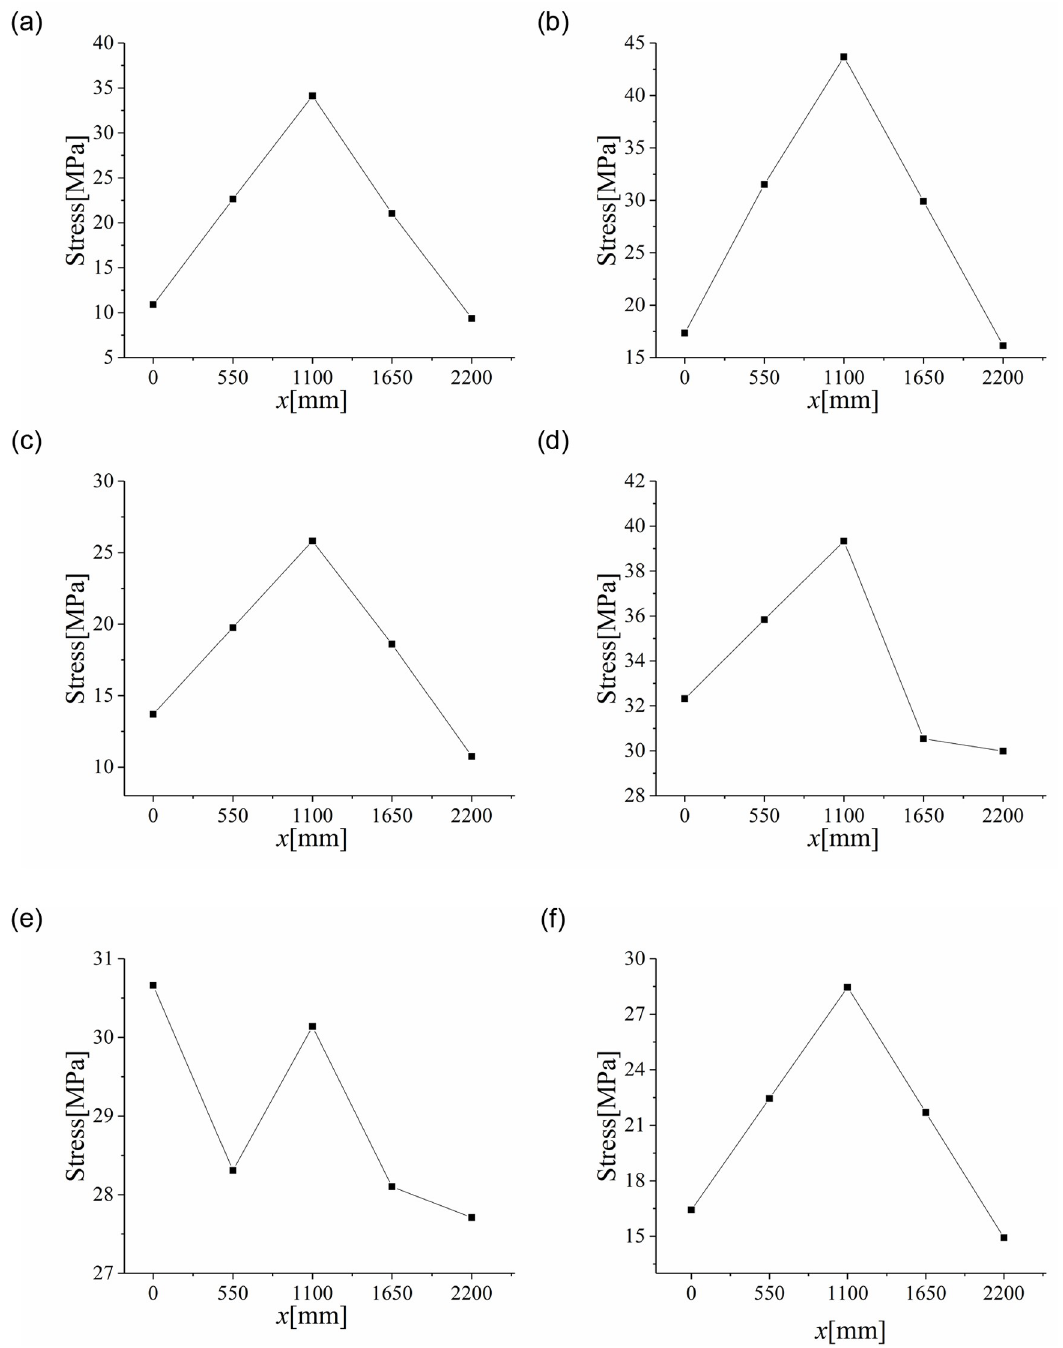
Fig 9. Correlation curves of control and central stress values with a uniform load. (a) SJ2; (b) SJ3; (c) SJ4; (d) SJ5; (e) SJ7; (f)